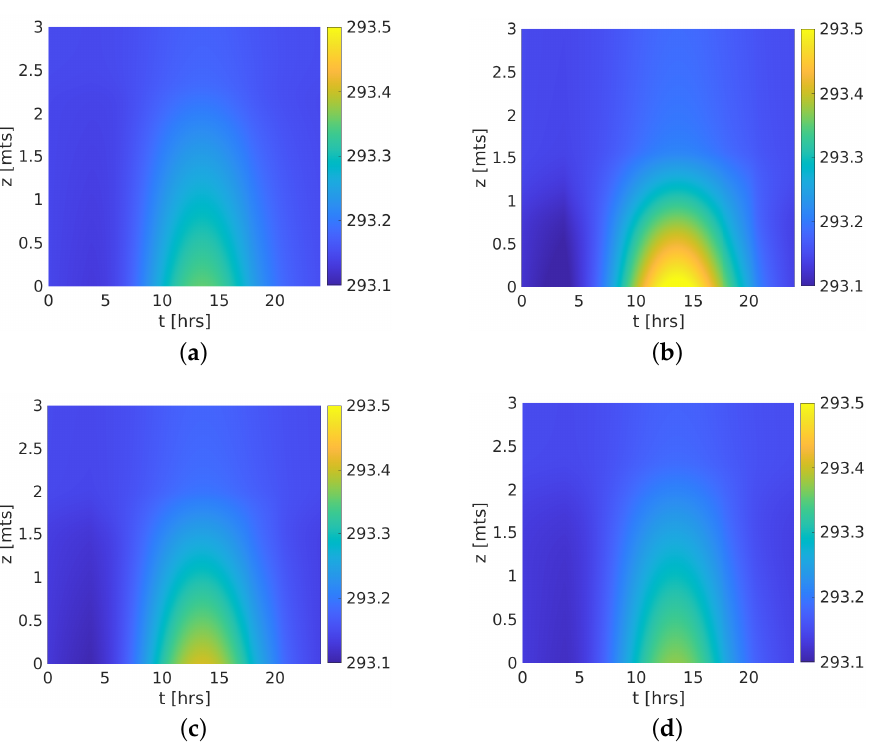
Figure 4. Air column temperatures at 24 h for all canopy shapes. ( a ) Case 1; ( b ) Case 2; ( c ) Case 3; ( d ) Case 4.